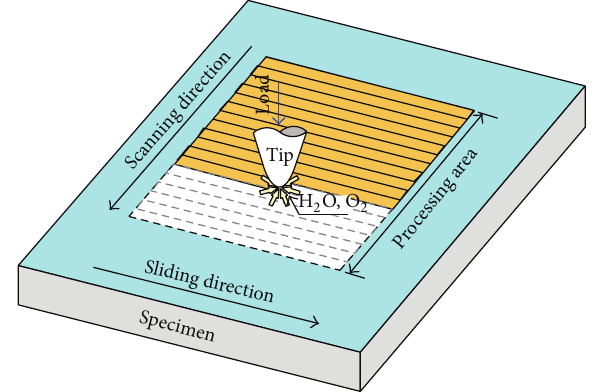
Figure 1: Mechanochemical processing of silicon by AFM tip